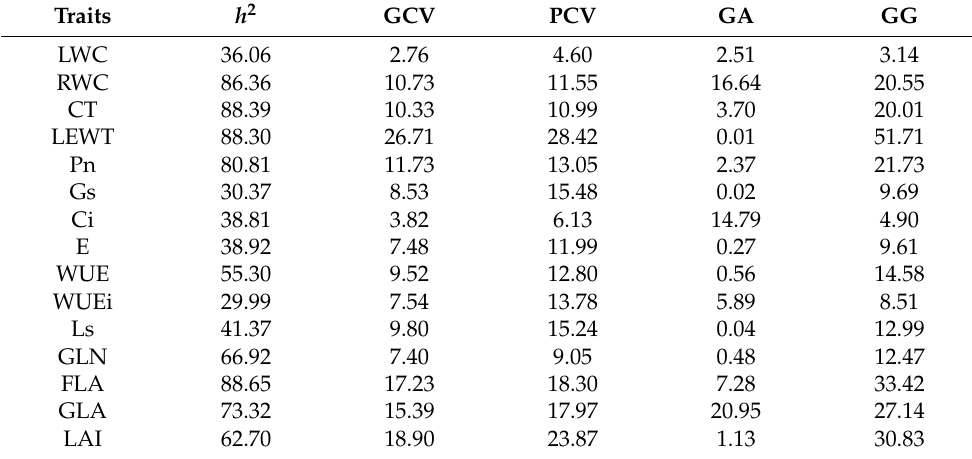
Table 3. Estimates of heritability ( h 2 ), genotypic coefficient of variance (GCV), phenotypic coefficient (PCV), genetic advance (GA), and genetic gain (GG) for 28 measured traits of 25 wheat genotypes in two seasons under two irrigation regimes